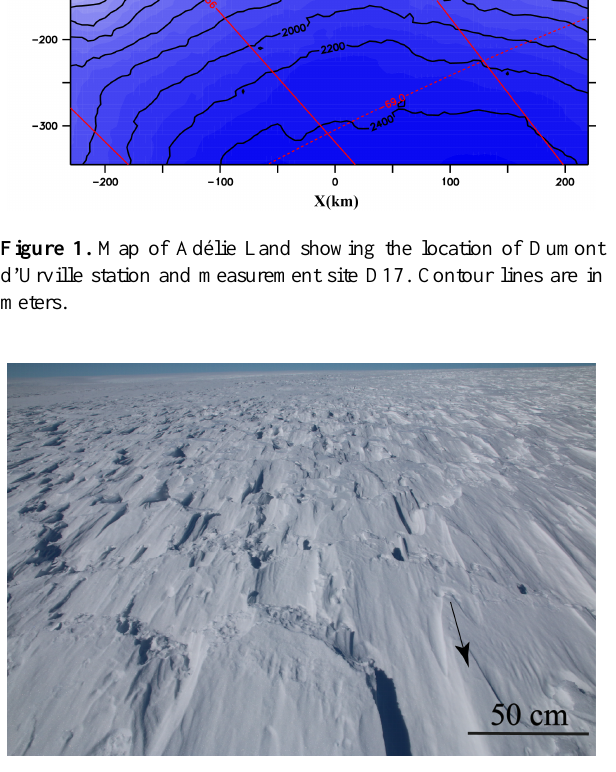
Figure 2. Photograph of the snow surface at D17 in January 2014. The arrow indicates the mean direction of the wind episode that led to the formation of the